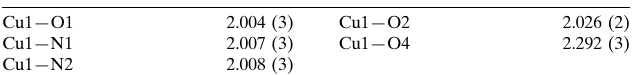
Selected bond lengths (A˚ ).